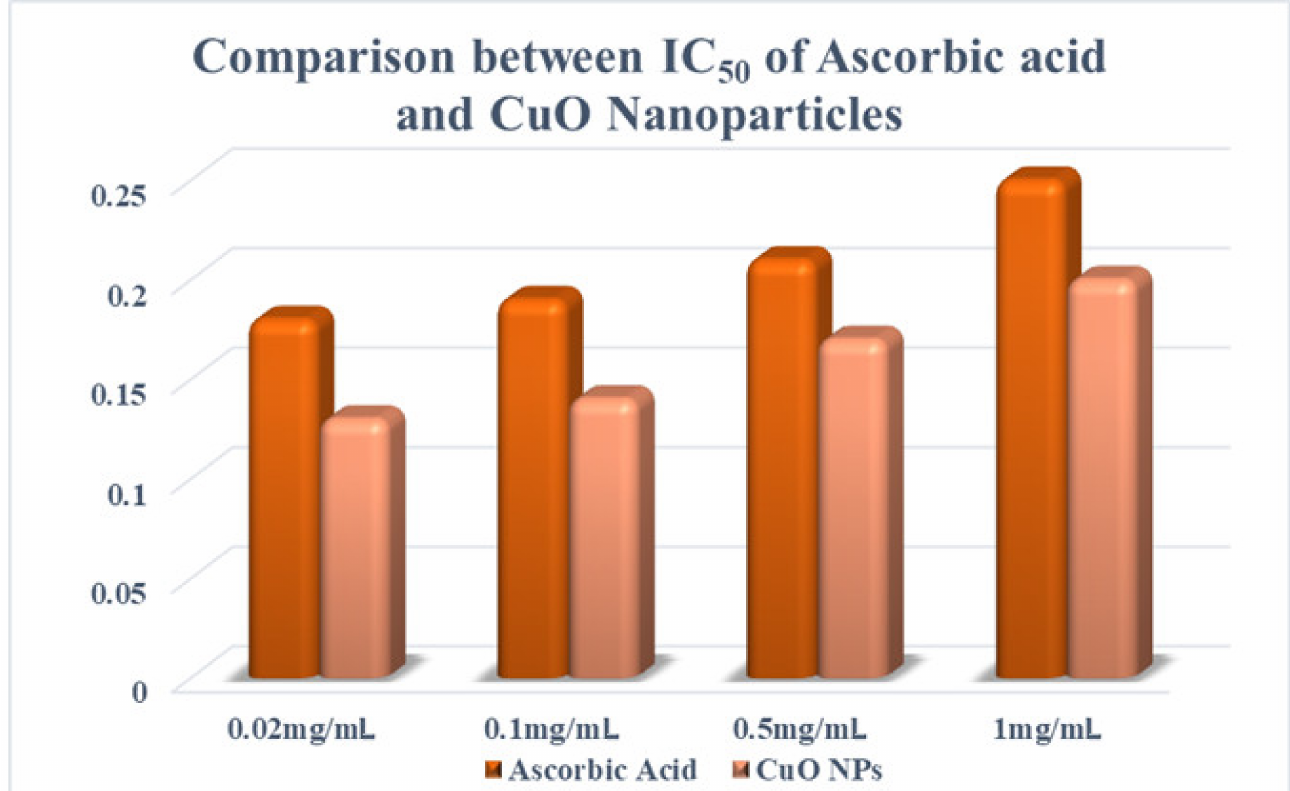
Figure 13. Comparison between IC 50 of ascorbic acid and CuO